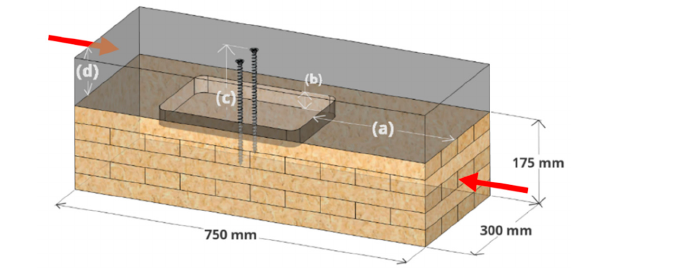
Figure 2. Diagram of a typical specimen, with indicated ( a ) heel length, ( b ) notch depth, ( c ) screw length, ( d ) concrete thickness.